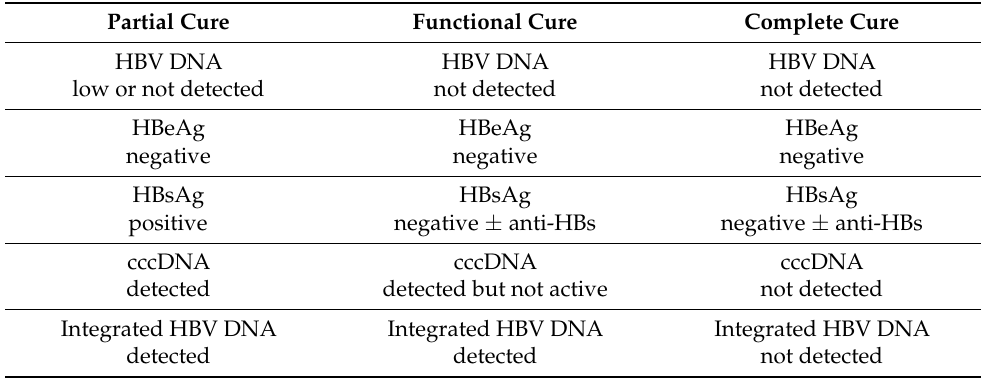
Table 1. Definition of partial, functional and complete HBV